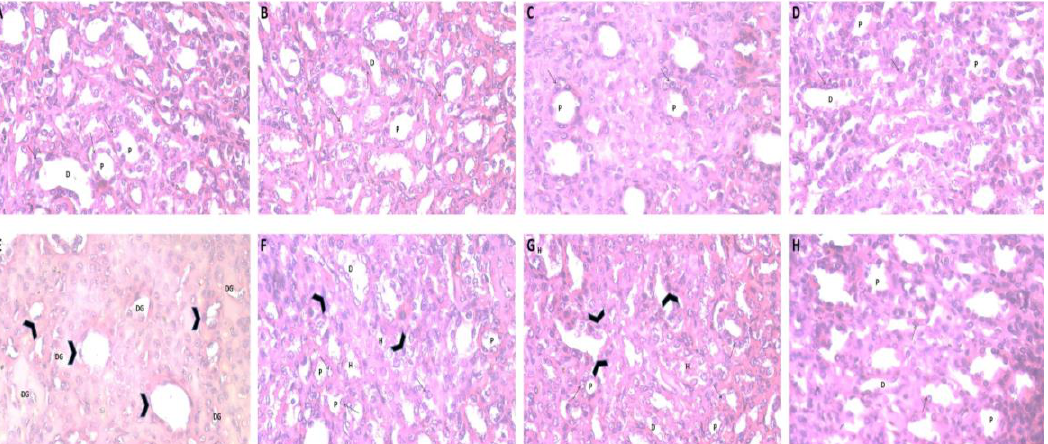
Fig. 4. Photomicrographs of histological sections of tubular structure of rats’ renal cortex by Hematoxylin and eosin. A: Control group; B: Negative control treated with sitagliptin; C: Negative control treated with oleuropein; D: Negative control treated with combination of sitagliptin and oleuropein, all show normal histological structure of rat's renal cortex with the proximal convoluted tubules (P) that are lined with high cuboidal cells with rounded vesicular basal nuclei (arrow) and deeply acidophilic cytoplasm, the distal convoluted tubules (D) have wider lumina and are lined with cubical cells with rounded vesicular central nuclei and paler acidophilic cytoplasm; E : Cisplatin treated rats have focal areas of marked tubular degeneration and dilation (DG), atrophied renal proximal and distal tubules with pyknotic and karryorrhetic nuclei (arrowhead); F and G : Cisplatin+ sitagliptin treated rats and Cisplatin+ oleuropein treated rats respectively, both groups show mild tubular recovery in form of intact cubical tubular cells with rounded vesicular central nuclei. Few tubules show cellular swelling and are having pyknotic nuclei (arrowhead) and hyalin cast (H), H : Cisplatin+sitagliptin+oleuropein treated rats show an improvement in tubular structure and minimal cellular